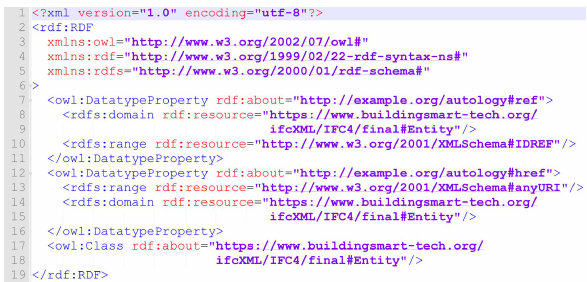
Figure 3. RDF/XML generated for Fig. 2